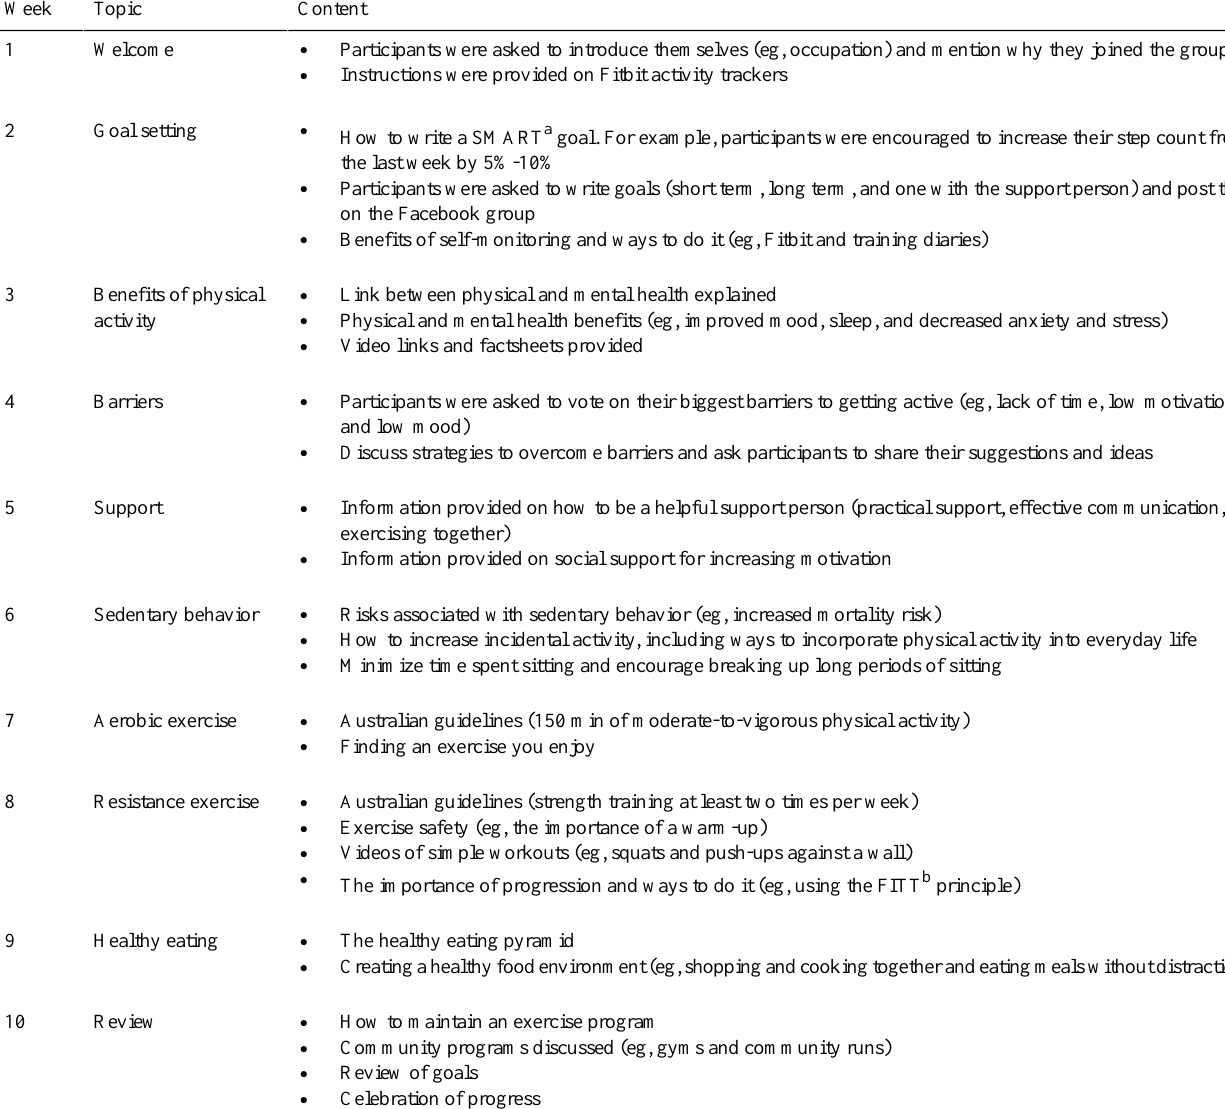
Table 1. Facebook group facilitator